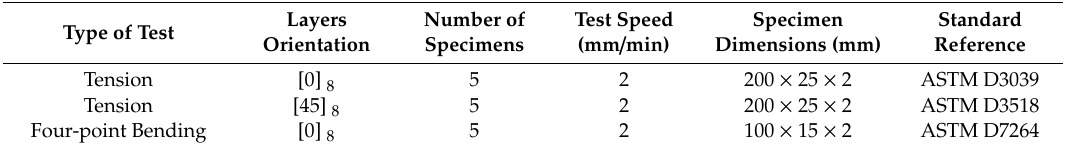
Table 2. Static characterization: Specifications of the experimental tests.